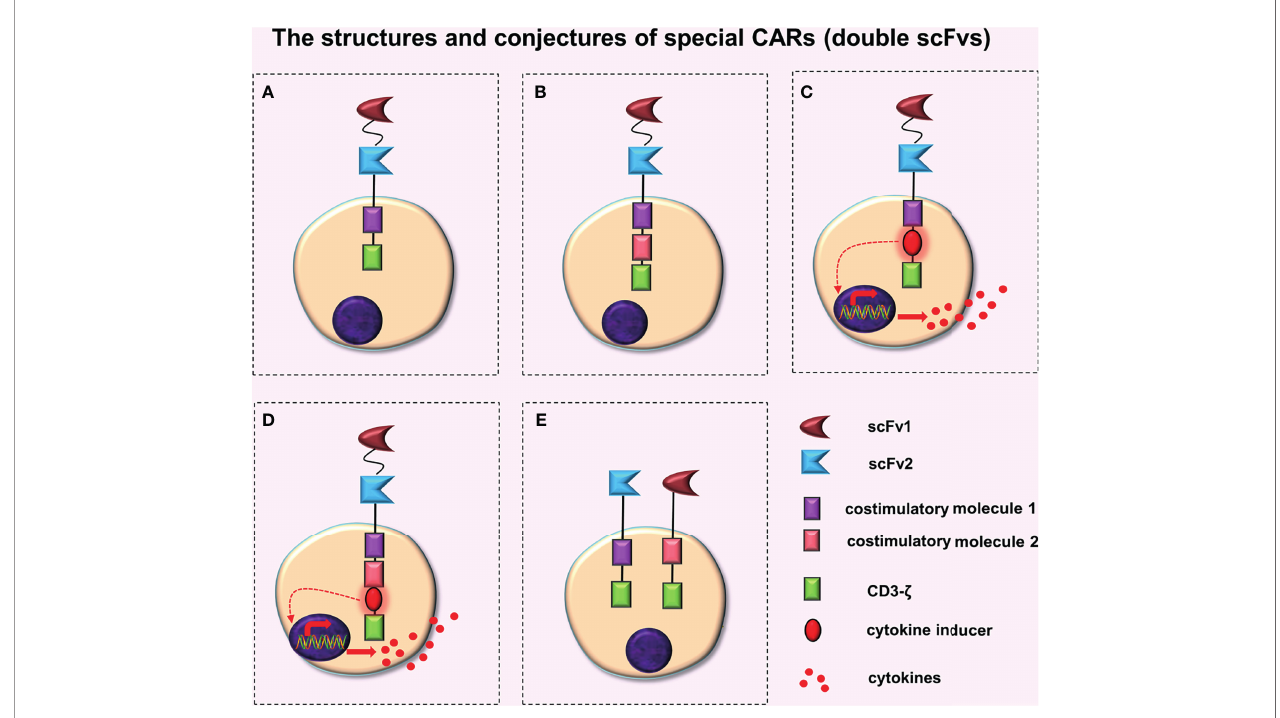
FIGURE 1 | The structures and conjectures of special CARs (double scFvs). Construction of a TanCAR based on the (A) second-generation CAR, (B) third- generation CAR, (C) fourth-generation CAR (the intracellular domain contains a costimulatory molecule), and (D) fourth-generation CAR (the intracellular domain contains two costimulatory molecules). (E) Construction of the dual-signaling CARs based on the second-generation